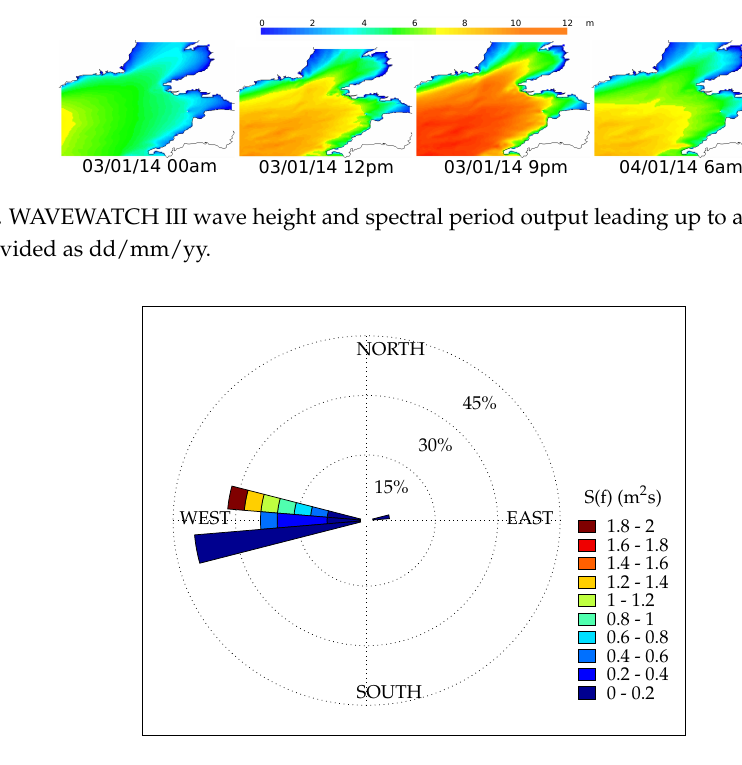
Figure 9. Spectral output from WAVEWATCH III model used to derive 60 minute wave train to force NEWRANS.